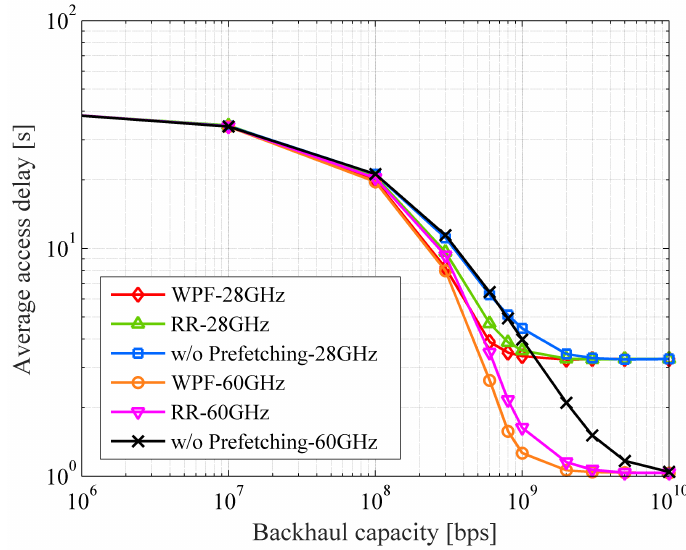
Figure 9. The average download time vs. the backhaul